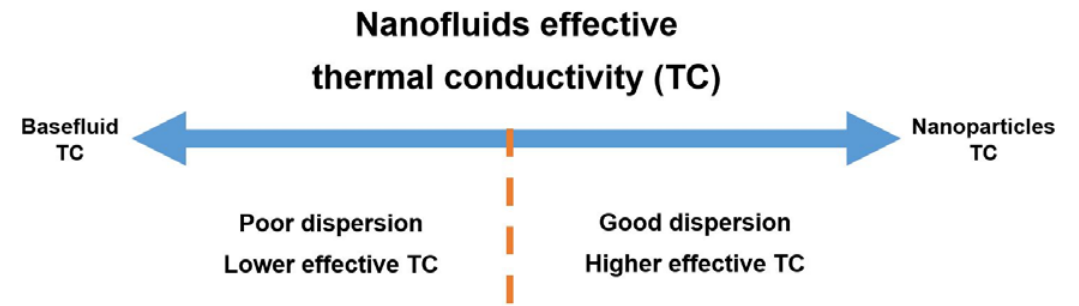
Figure 7. Relation between nanofluid stability and its effective thermal conductivity.